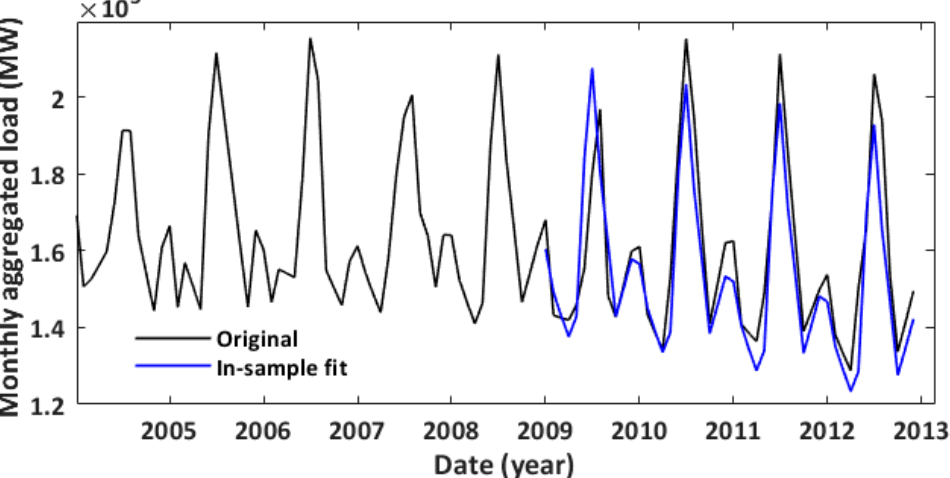
Figure 8. In-sample model fit for years 2009–2012 with a Mean Absolute Percentage Error (MAPE) of 4.98%.